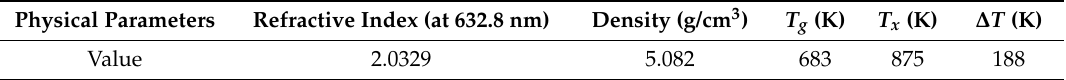
Table 1. Basic physical parameters of Er 3+ /Yb 3+ codoped TZNb glass